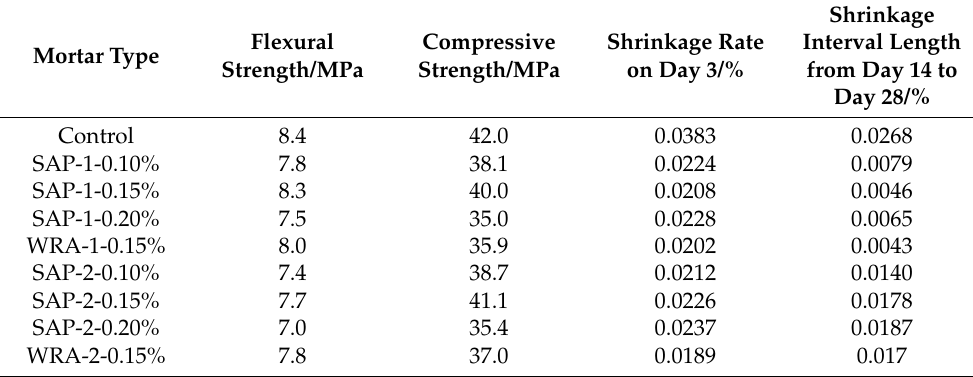
Table 4. Performance test results of